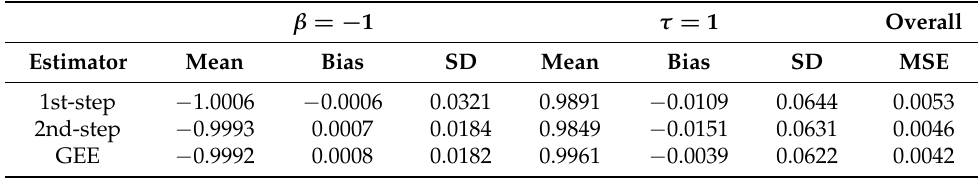
Table 1. Simulation result: non-linear model.